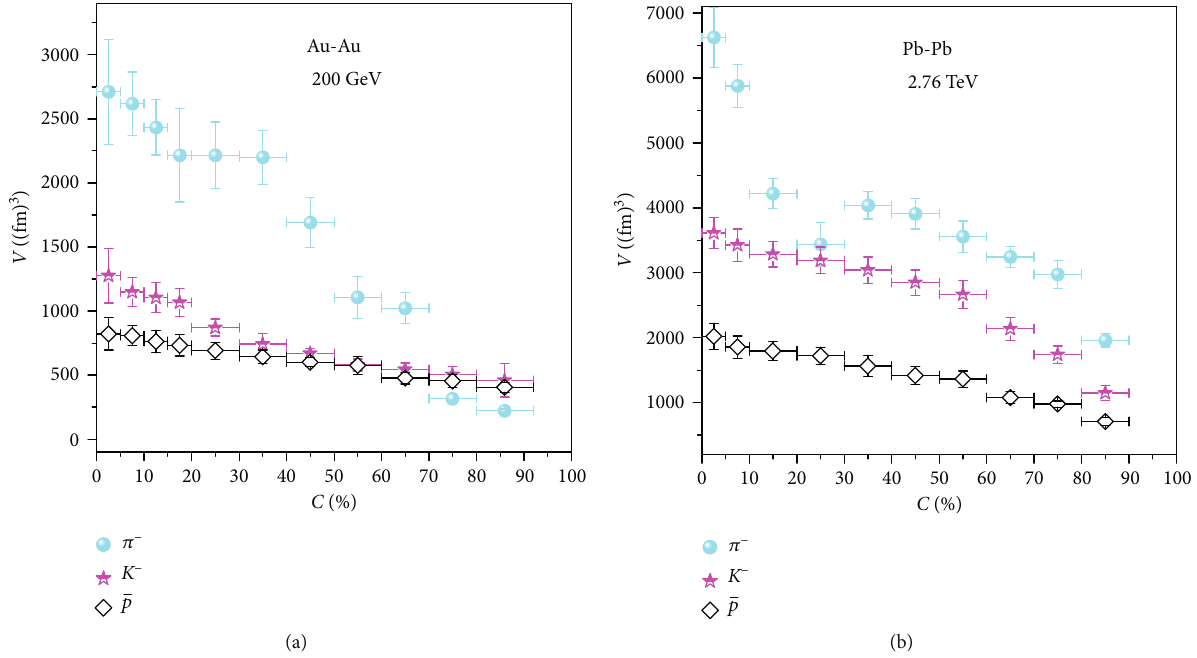
Figure 4: Same as Figure 3, but for dependence of kinetic freeze-out volume V on centrality C